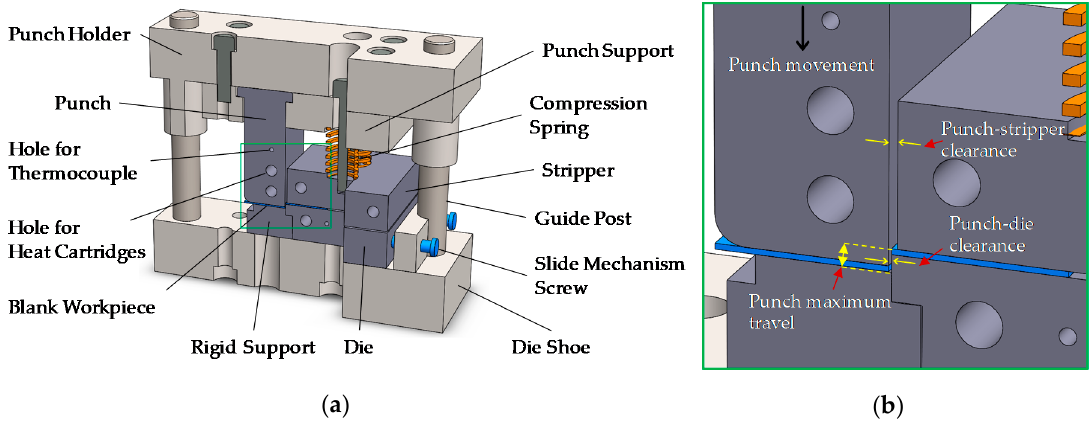
Figure 3. ( a ) Main components of the blanking device (sectional view); ( b ) magnified illustration of the selected blanking parameters.